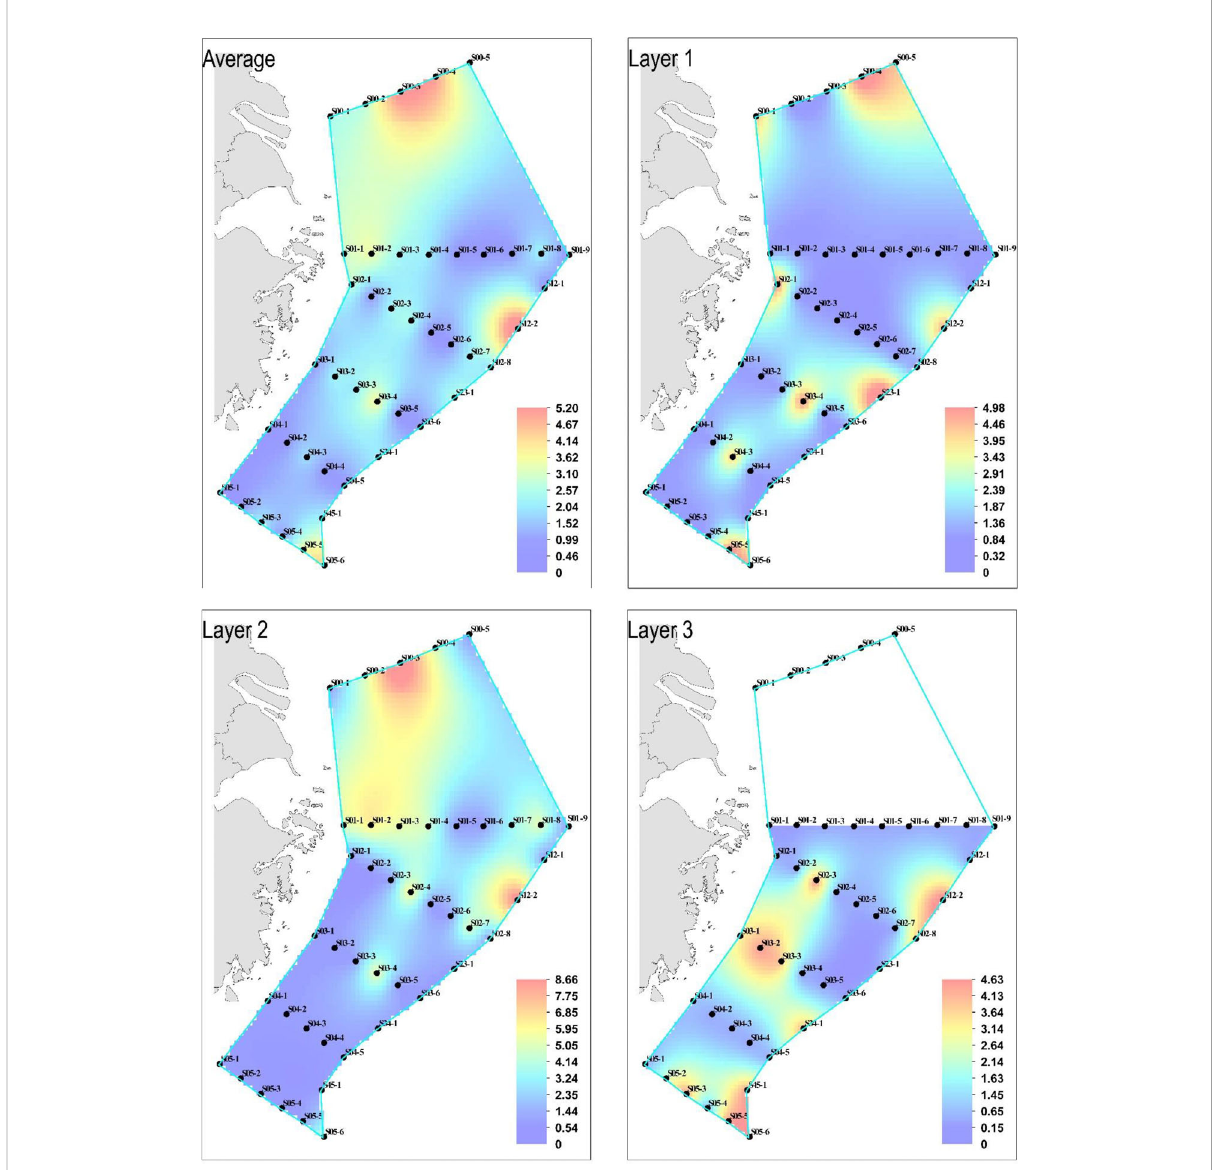
FIGURE 3 Horizontal distributions of black sea bream in the East China Sea. Black dots indicate sampling stations. The x-axis and the y-axis represent the longitude and the latitude, respectively. Concentrations of environmental DNA (eDNA) are depicted with gradient colors. Color bar scales indicate the log-transformed eDNA concentrations. Layer 1 (surface), Layer 2 (10 – 50 m), and Layer 3 (50 – 104